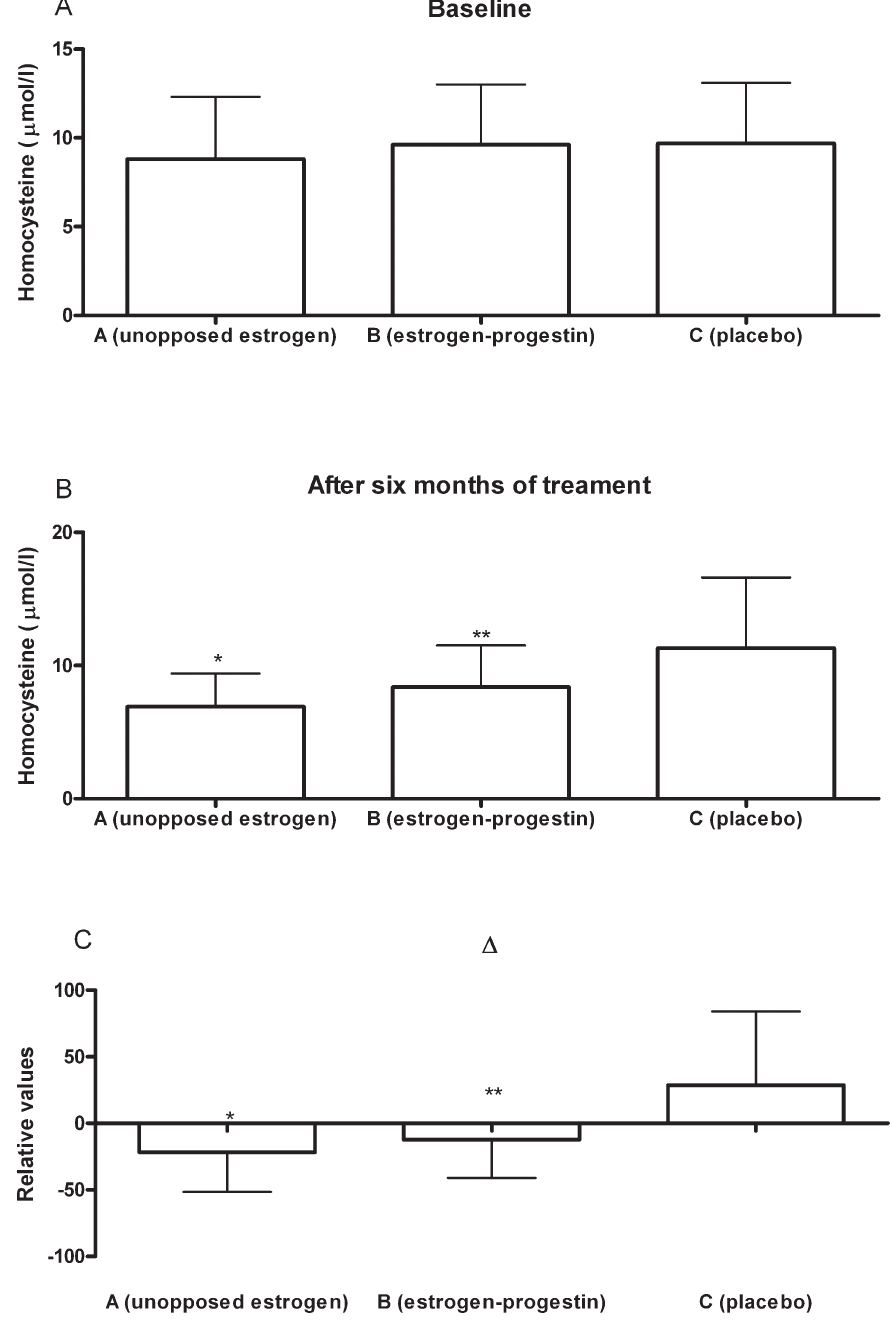
Figure 1 - Graphical representation of homocysteine values during the study: a) baseline; b) after six months of treatment; c) delta {( D = [(value after treatment - baseline value)/baseline value * 100]}. * p , 0.01 compared with the other groups; ** p , 0.01 compared with